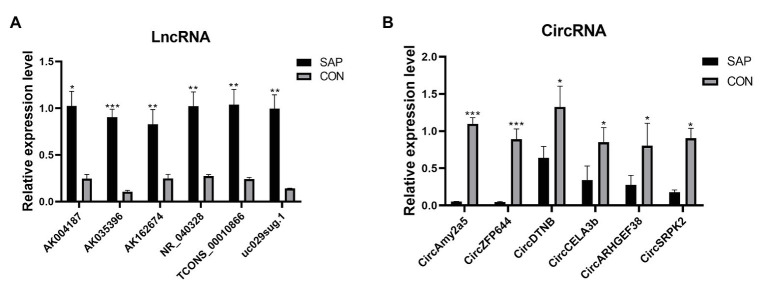
qRT-PCR validation of DELs and DECs in SAP rats compared with matched tissues of control rats. (A) The expression level of lncRNA AK004187, AK035396, AK162674, NR_040328, uc029sug.1, TCONS_00010866. (B) The expression level of circRNA CircAmy2a5, CircZFP644, CircDTNB, CircCELA3b, CircARHGEF38, and CircSRPK2. *represents p < 0.05, **represents p < 0.01, and ***represents p < 0.001.